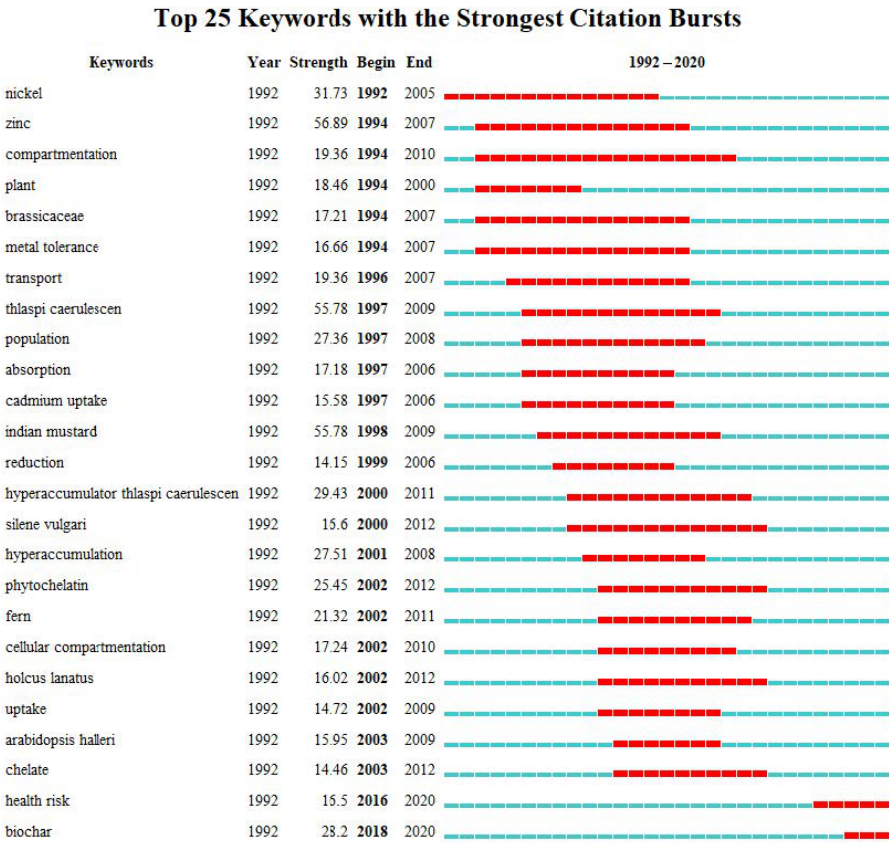
Figure 7. Keywords with the strongest citation bursts developed by CiteSpace. Blue indicates the time when keywords appear, and red indicates the time when keywords burst.